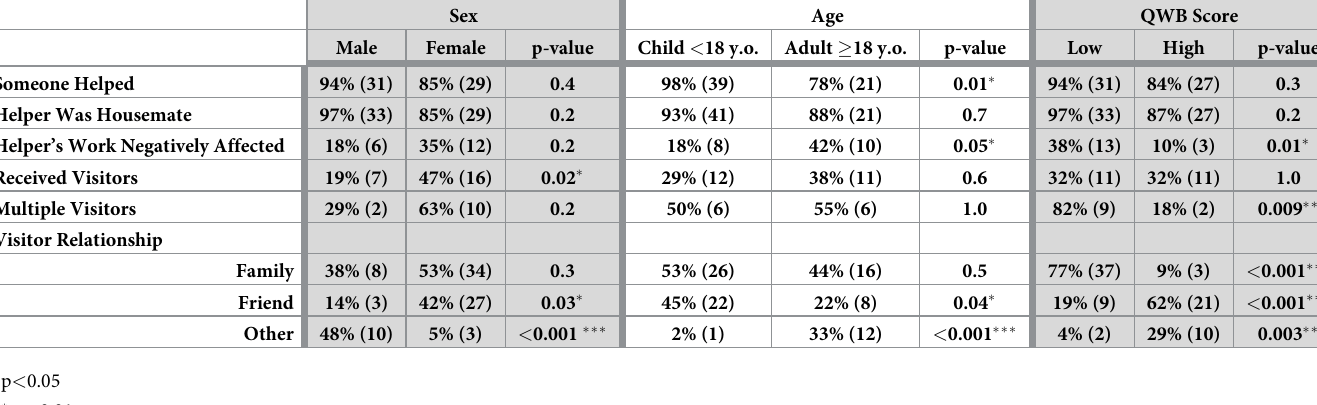
Table 1. Differences in caregiving and visitor behaviors experienced by symptomatic DENV infected individuals in Iquitos, Peru, compared by sex, age, and Quality of Well-Being (QWB) score. Fisher’s Exact tests were performed for variables (1)whether caregiving was received, (2)if the person who helped was their housemate, (3) if the person who helped had their work negatively affected, (4) if visitors were received during the illness period, (5) whether one or two visitors were received, and (6) what the relationship of the visitor was (family/friend/other). The percent of each group (and the raw number of participants) that experienced a behavior is listed, as is the p- value for the Fisher’s Exact test. Participants’ minimum QWB score during illness were split into two equal groups, ‘Low’ and ‘High’, where those with ‘Low’ QWB scores had the worse health-related quality of life during illness. Variables (1),(4), and (5) were examined at the participant level, whereas (2),(3), and (6) were examined at the vis- itor/helper level. For variables (1)-(6) the overall N values in the first 2 columns (sex and age) were 67, 68, 68, 70, 23, and 85, respectively. As there were 2 participants with- out QWB scores available, overall N values in the QWB score column were 65, 65, 65, 68, 22, and 82, respectively.